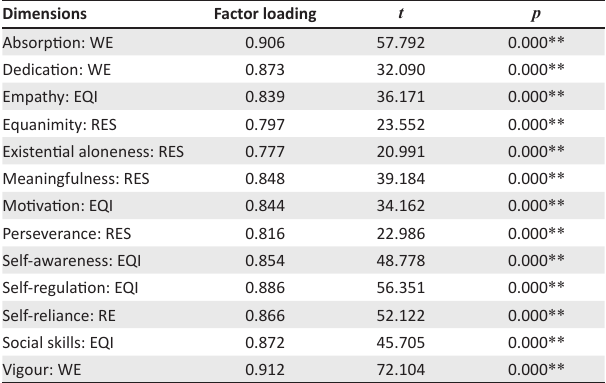
TABLE 5: Outer loadings - loading of dimensions on the latent variable. Dimensions